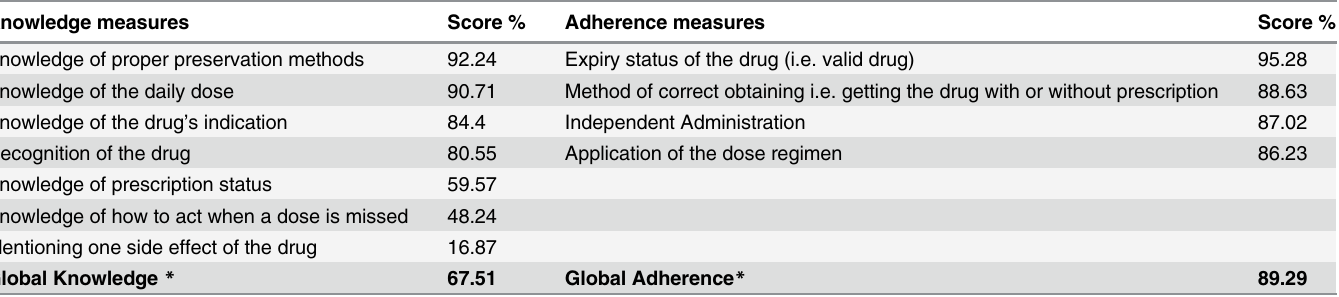
Table 2. Scores of knowledge and adherence measures ranked from highest to lowest